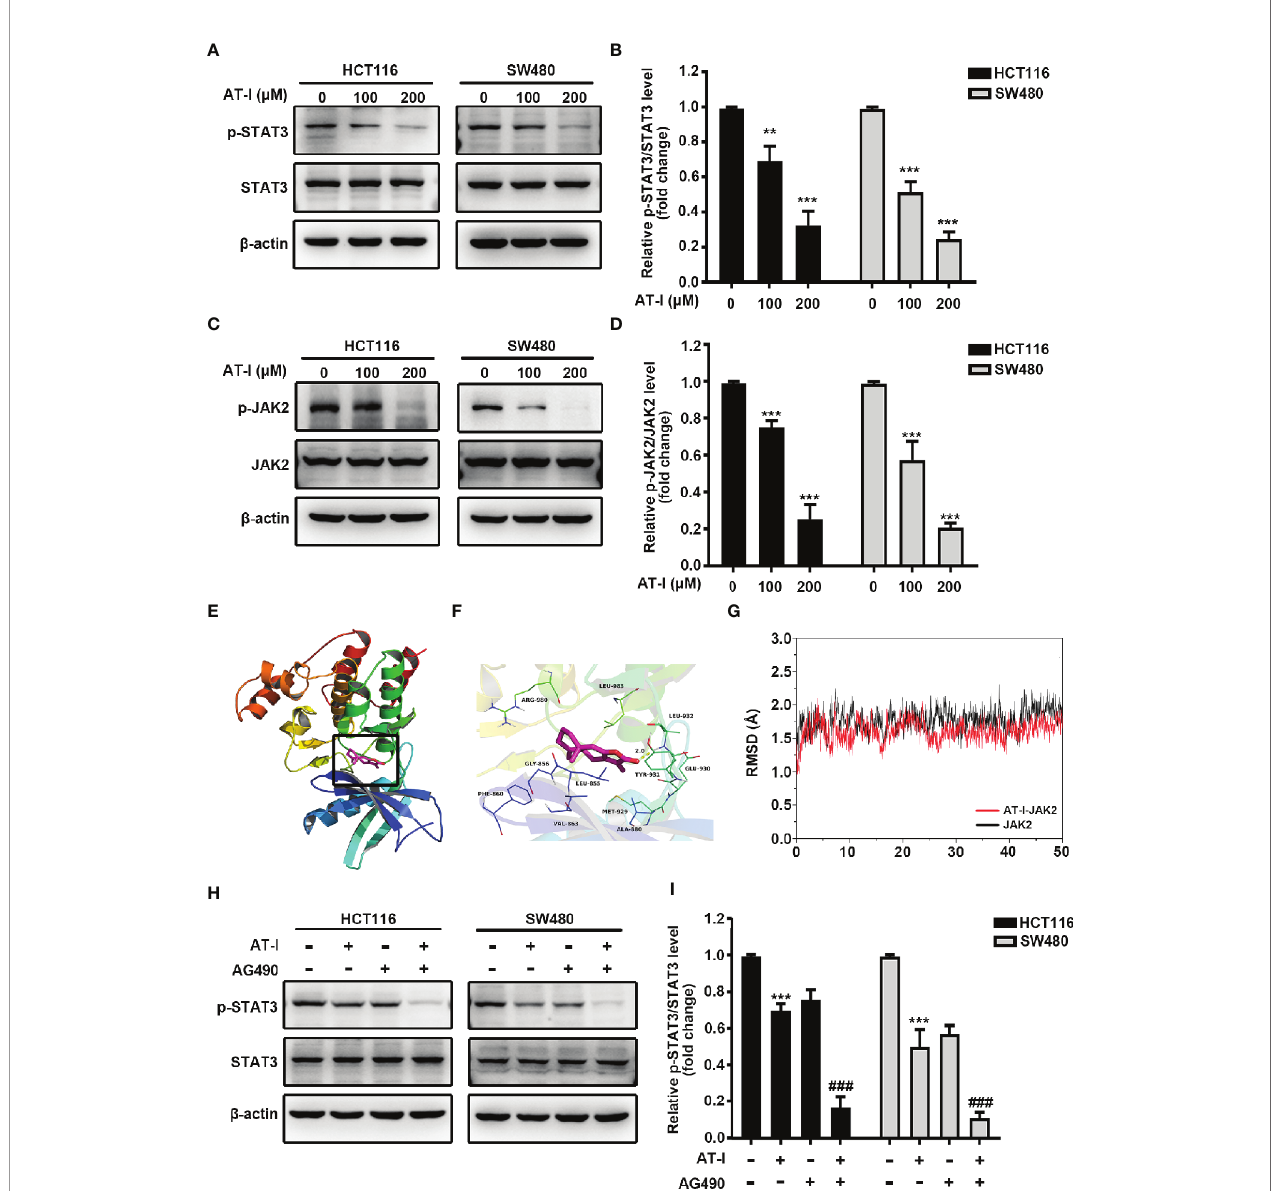
FIGURE 4 | AT-I induced inactivation of JAK2/STAT3 signaling pathway in CRC cells. (A) Western blot analysis of p-STAT3 (Tyr705) and STAT3 in CRC cells treated with AT-I for 24 h. (B) P-STAT3 (Tyr705) levels were normalized to STAT3 levels, and these are shown as fold changes relative to the control group levels. (C) Western blot analysis of p-JAK2 and JAK2 and quanti fi cation of the results. (D) P-JAK2 levels were normalized to those of JAK2 levels and are shown as fold changes relative to the control group levels. (E) AT-I docking onto JAK2 using computer modeling. (F) Strong and stable hydrogen bonds between AT-I and Leu- 932 of JAK2 (in yellow). (G) RMSD pro fi le of AT-I complex with JAK2 and JAK2 Apo during the 50 ns MD simulation. (H) Western blot analysis of p-STAT3 and STAT3, after treatment with AT-I and AG490 as indicated. (I) P-STAT3 (Tyr705) levels were normalized to those of STAT3 and are shown as fold changes relative to the control group levels. ** p < 0.01 and *** p < 0.001 compared with the control group without any treatment. ### p < 0.001 compared with the AT-I treated